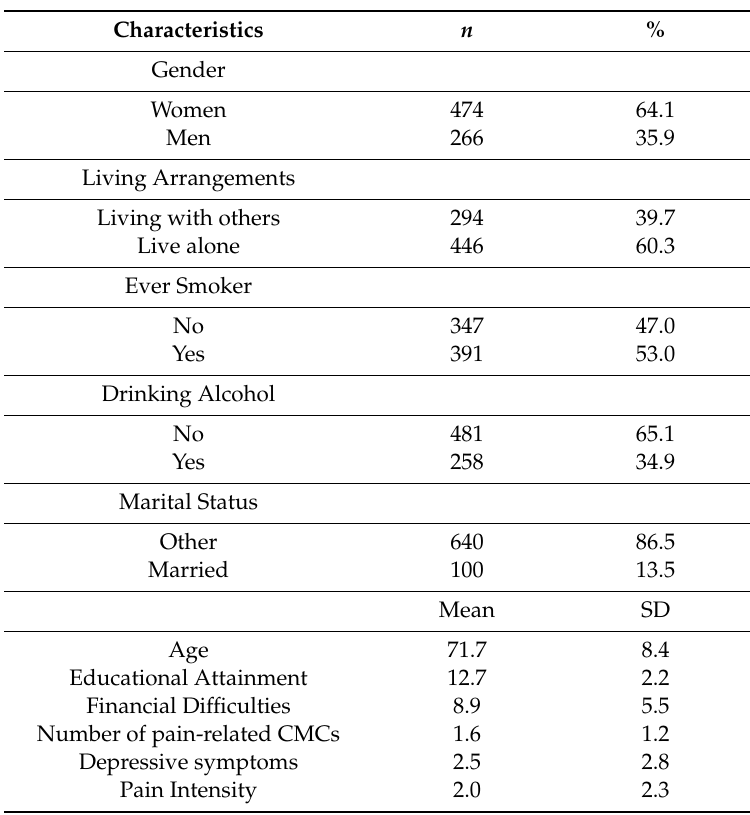
Table 1. Descriptive statistics in the pooled sample ( n =